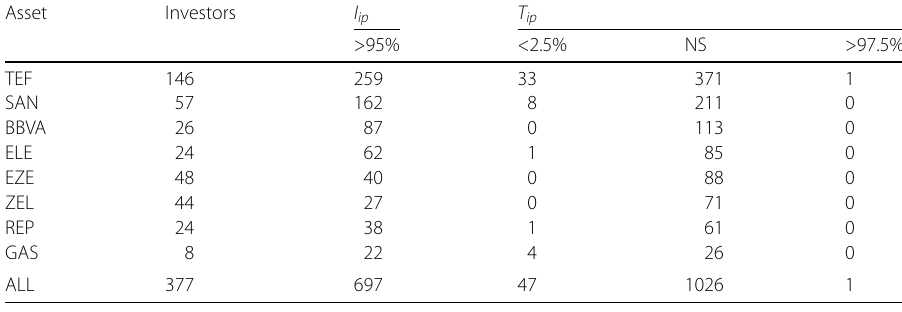
Figure 4 Synchronization with price as driver of synchronization between investors. Axis x and y represent deciles so that generate a 10 × 10